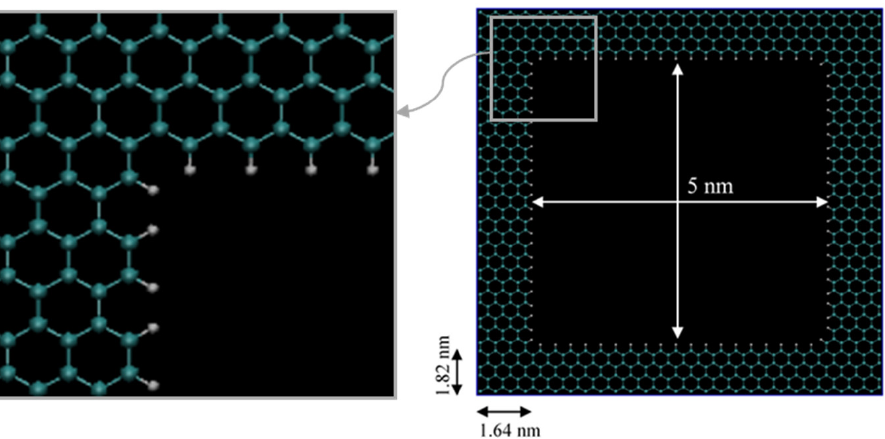
Figure 2. Graphene sheet structure. The dangling bonds are connected to (-H). Cyan and white are carbon and hydrogen atoms, respectively.